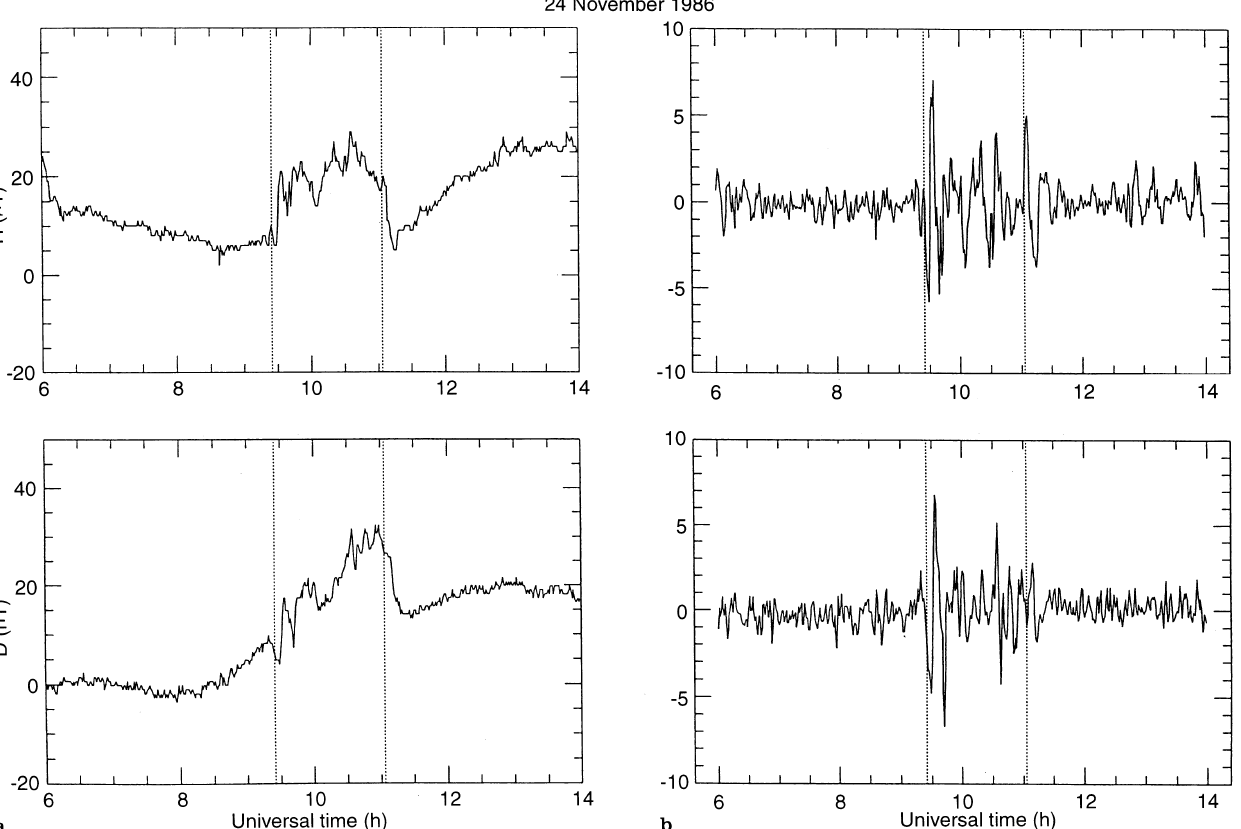
Fig. 1a,b. The H and D components in nT after subtracting the daily average value ( upper and lower panel respectively) at L’Aquila Observatory on November 24, 1986. Dotted lines indicate the interval associated with the passage of the high pressure solar wind region at IMP 8